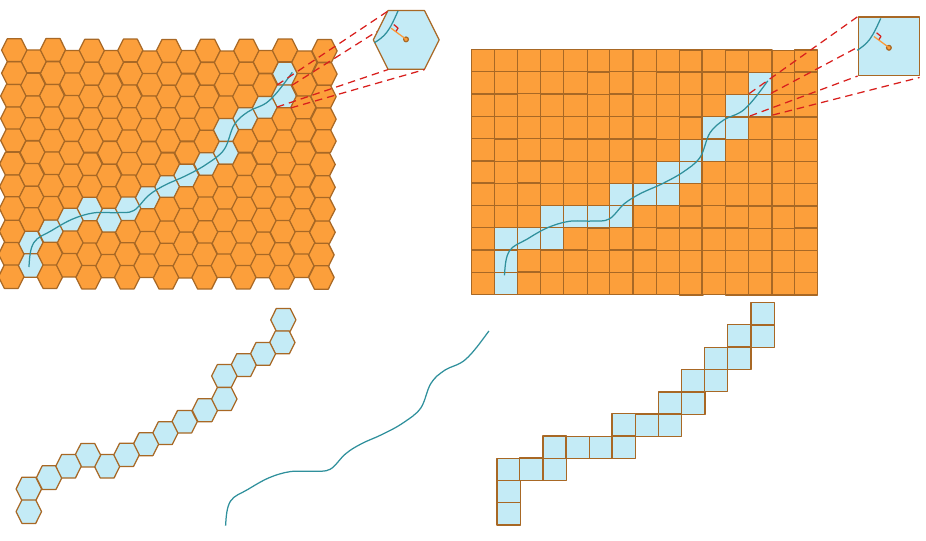
Figure 4: Schematic diagram of the grid model error. Table 4: Correspondence between the ISEA4H hexagonal grids and the quadrilateral